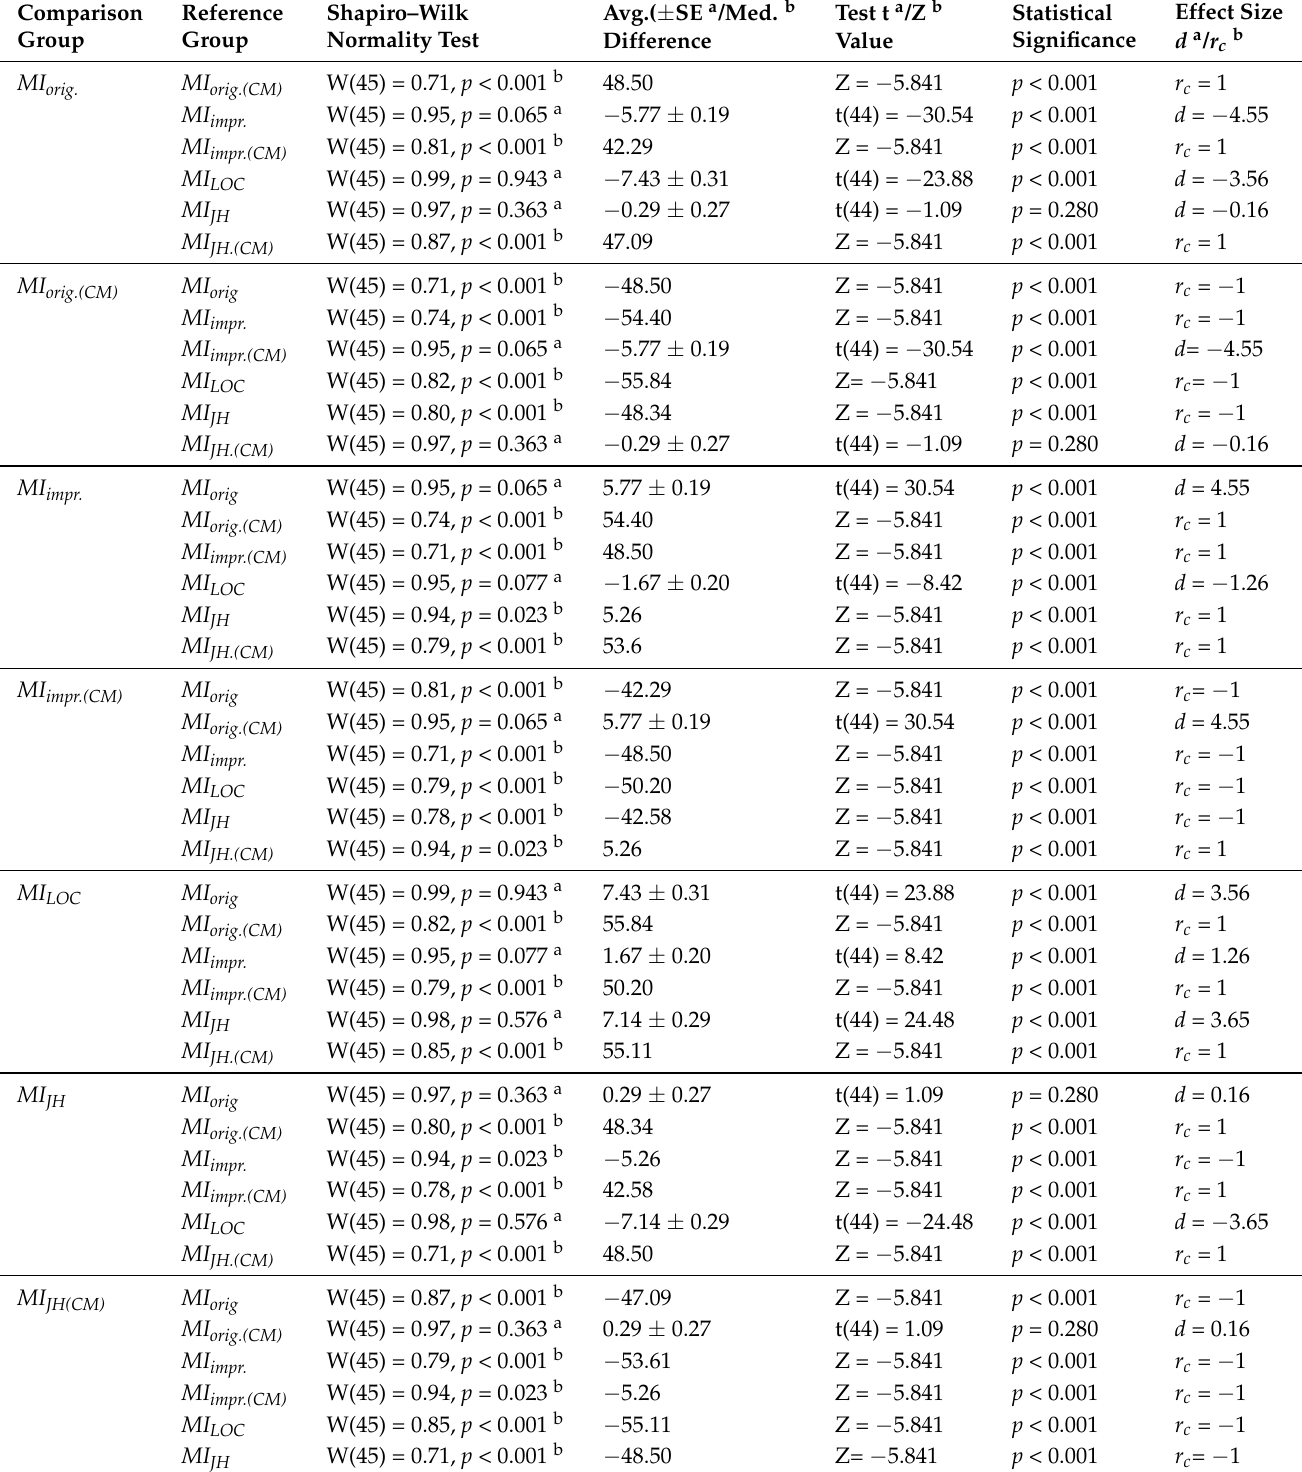
Table 10. Evaluation of the differences between the paired observations of Index variant